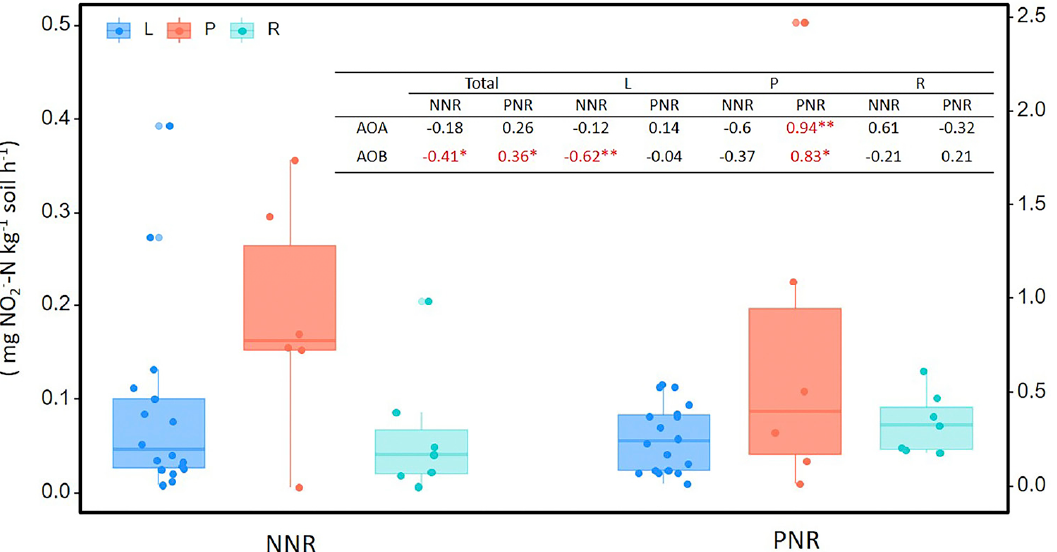
Figure 3. The net nitrification rate (NNR) and the potential nitrification rate (PNR) in soils from lacustrine (L), palustrine (P), and riverine (R) wetlands. The table shows the Spearman’s r and the statistical significance of the ammonia-oxidizers abundances correlated to NNR and PNR in total and different wetlands (** p < 0.01, * p < 0.05).